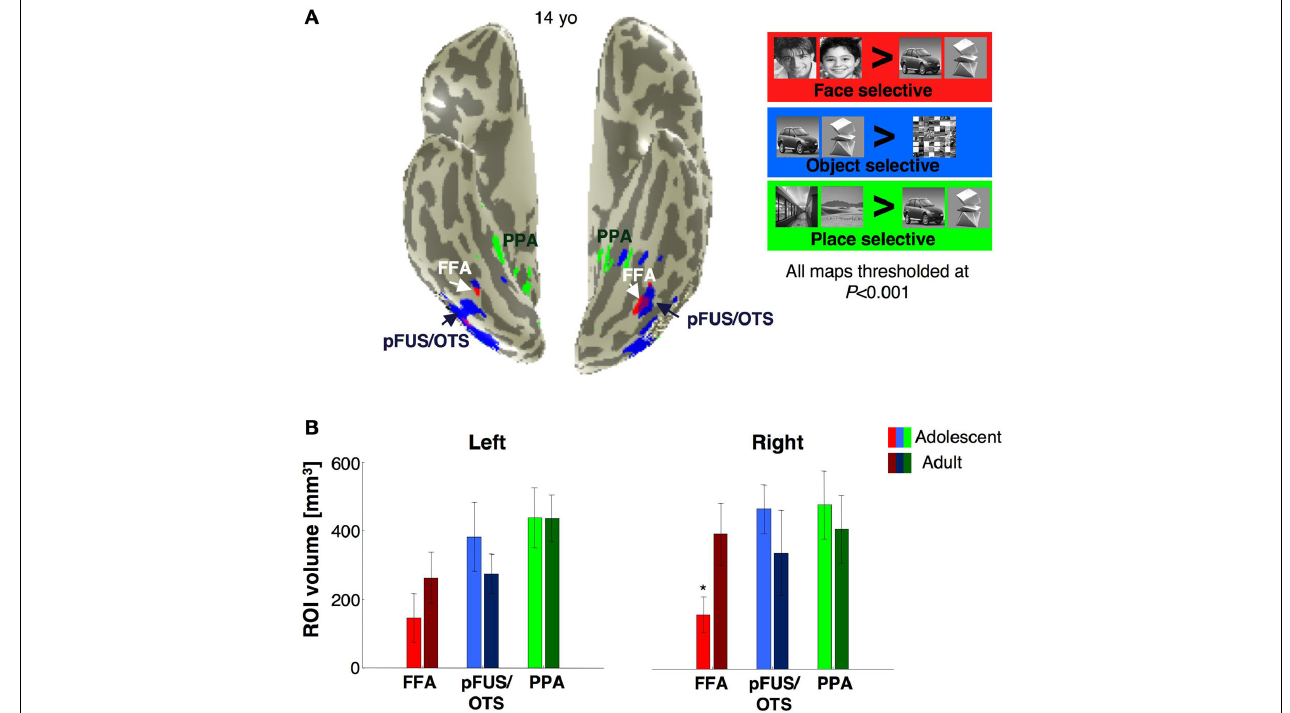
FIGURE 7 | Face-, object- and place selective activations in ventral cortex. (A) Face (red), object (blue) and place (green) selective activations in a representative 14-year-old subject. All activation maps are plotted at the P < 10 –3 threshold, uncorrected. Overlapping face and object activations are shown in magenta. The spatial relation among face, object and place selective activations